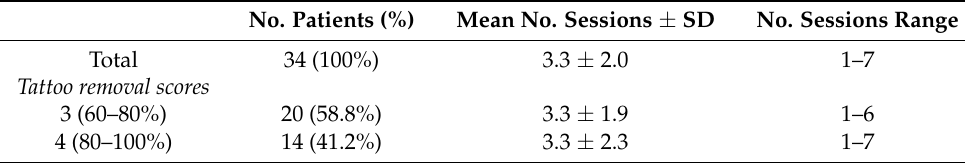
Table 3. Tattoo removal scores.